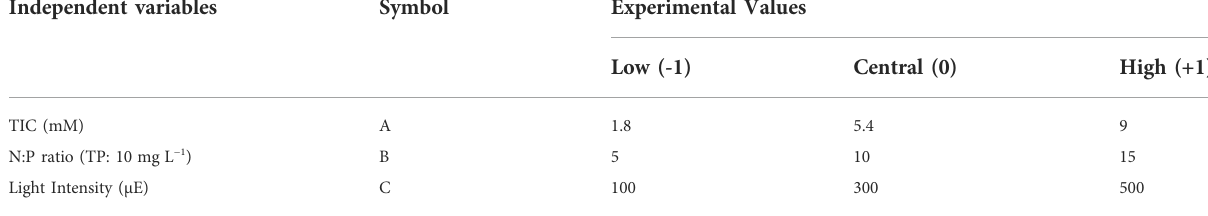
TABLE 2 Actual and coded levels of the independent variables of the Box – Behnken design (BBD). TIC, total inorganic carbon; N:P, nitrogen-to- phosphorus ratio; TP, total phosphorous. Independent